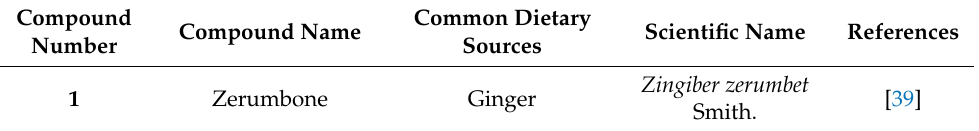
Table 2. Common dietary sources of terpenoid phytochemicals that can modulate the Keap1-Nrf2- ARE signaling